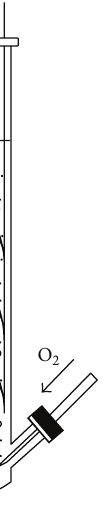
Figure 1: Experimental set-up. (A) UV lamp, (B) thermometer, (C) magnetic stirrer, (D) gas outlet and sampling, and (E) oxygen